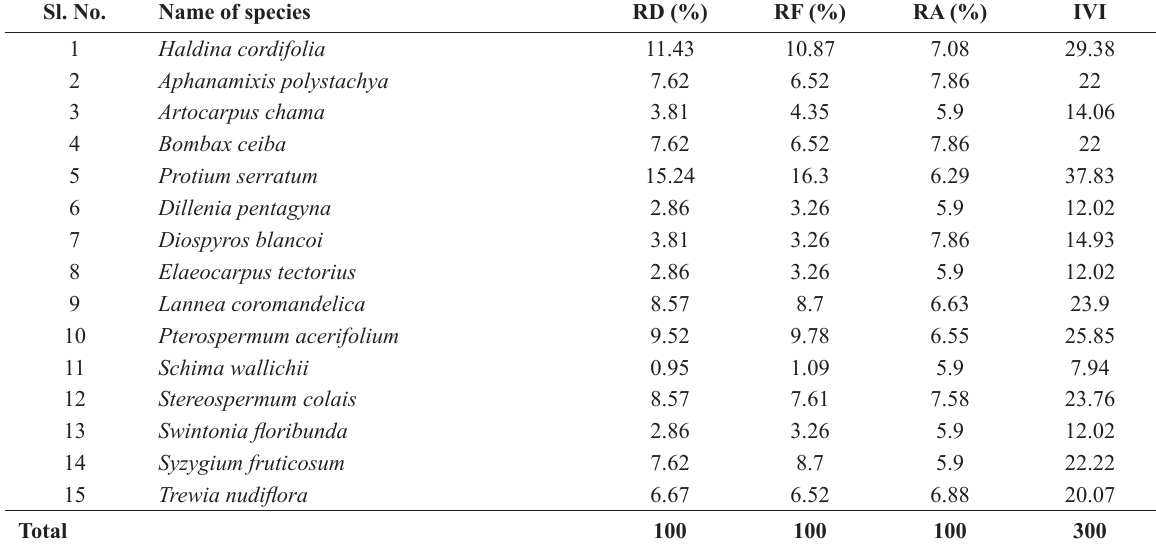
Table 5 : Quantitative structure of the seedlings naturally occurring in Rampahar Forest Reserve. [ here, RD = Relative Density, RF = Relative Frequency, RA = Relative Abundance, IVI = Importance Value Index ] Sl.